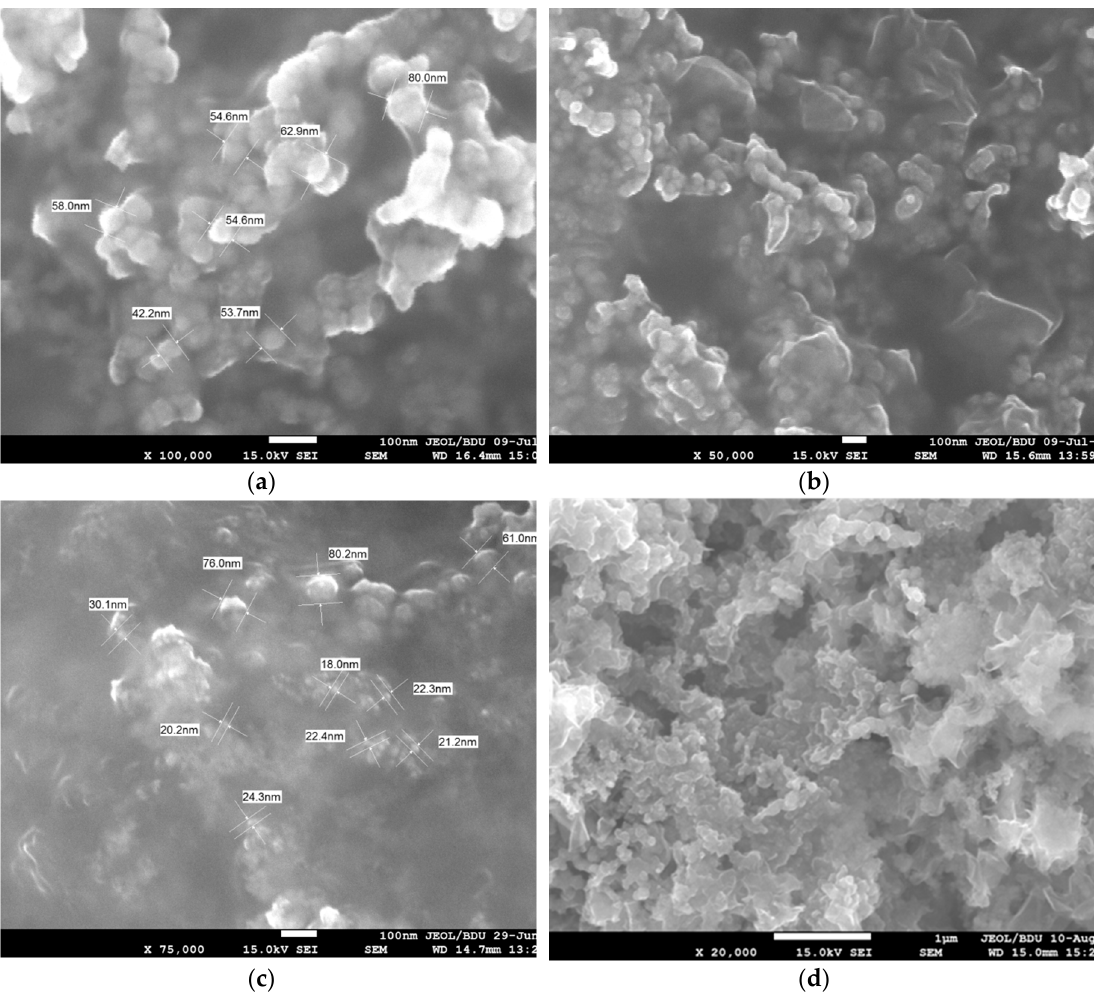
Figure 1. SEM images of zerovalent iron (nZVI) nanoparticles ( a , b ) and 0.5% Ni loading Fe/Ni bimetallic nanoparticles ( c , d ).